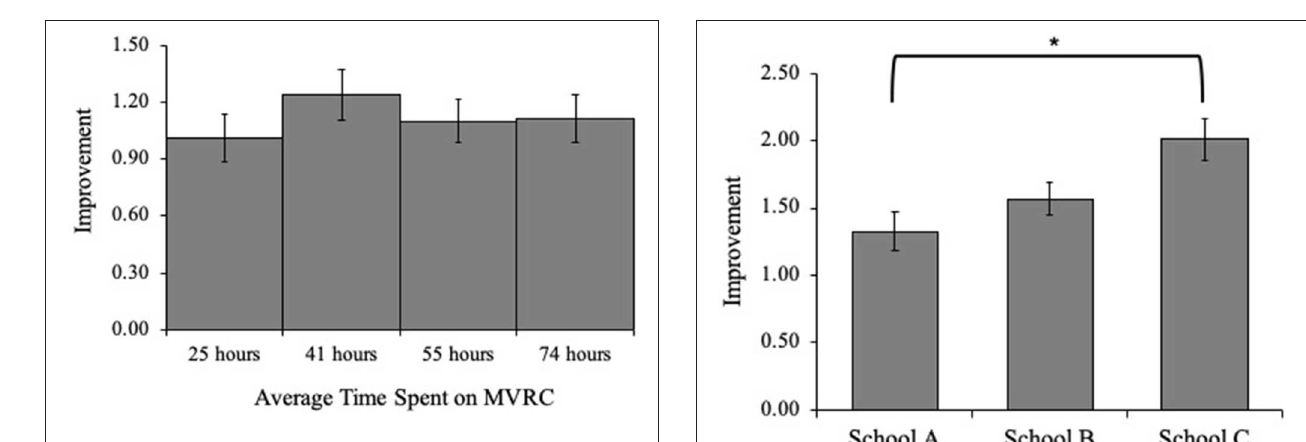
FIGURE 3 | Average improvement of 4th-grade reading fluency, as a function of hours practiced (separated into quartiles). Error bars represent standard errors.